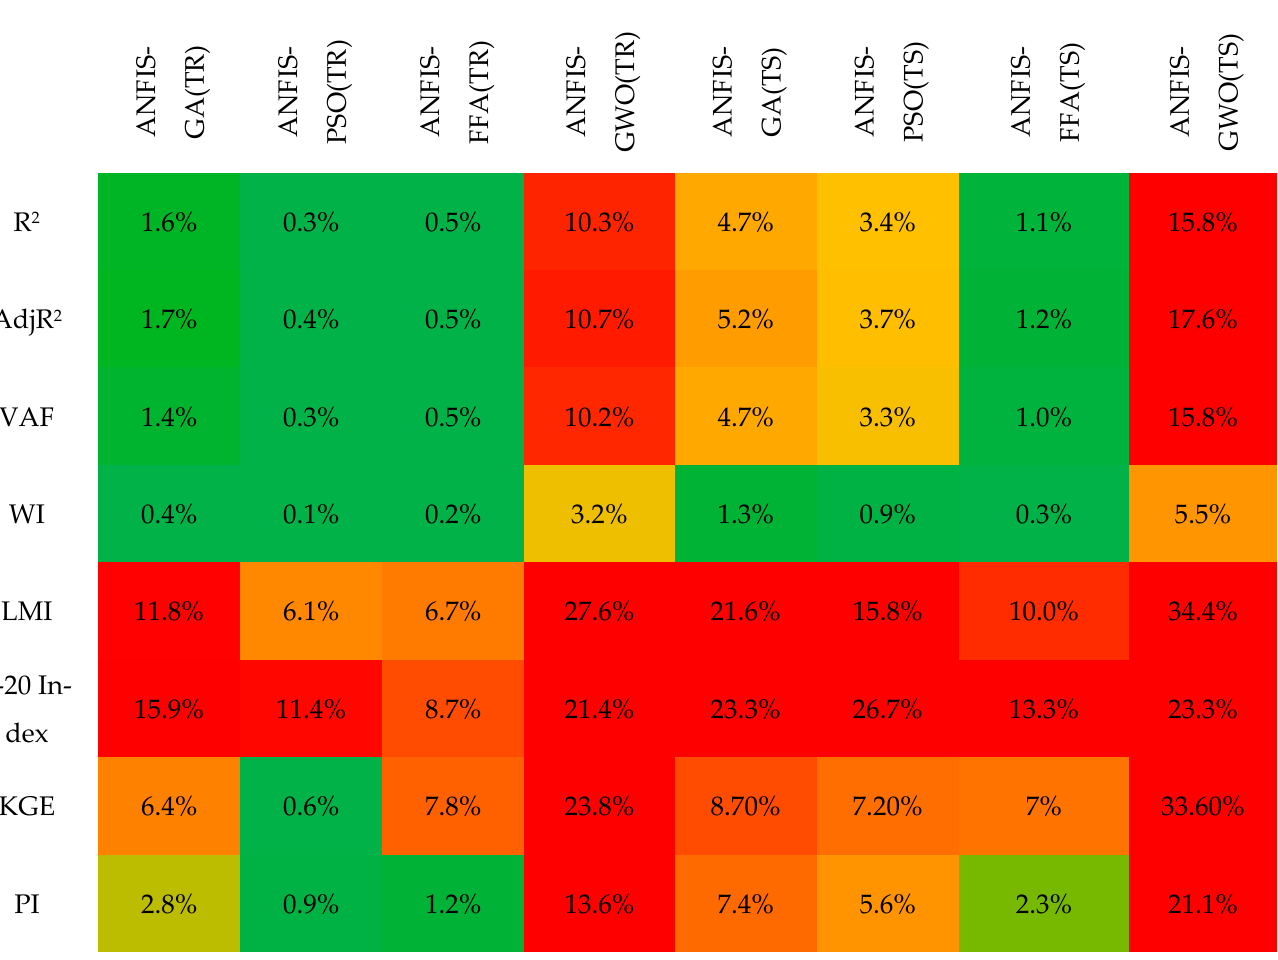
Figure 11. Error matrix for trend measuring parameters (training and testing dataset).